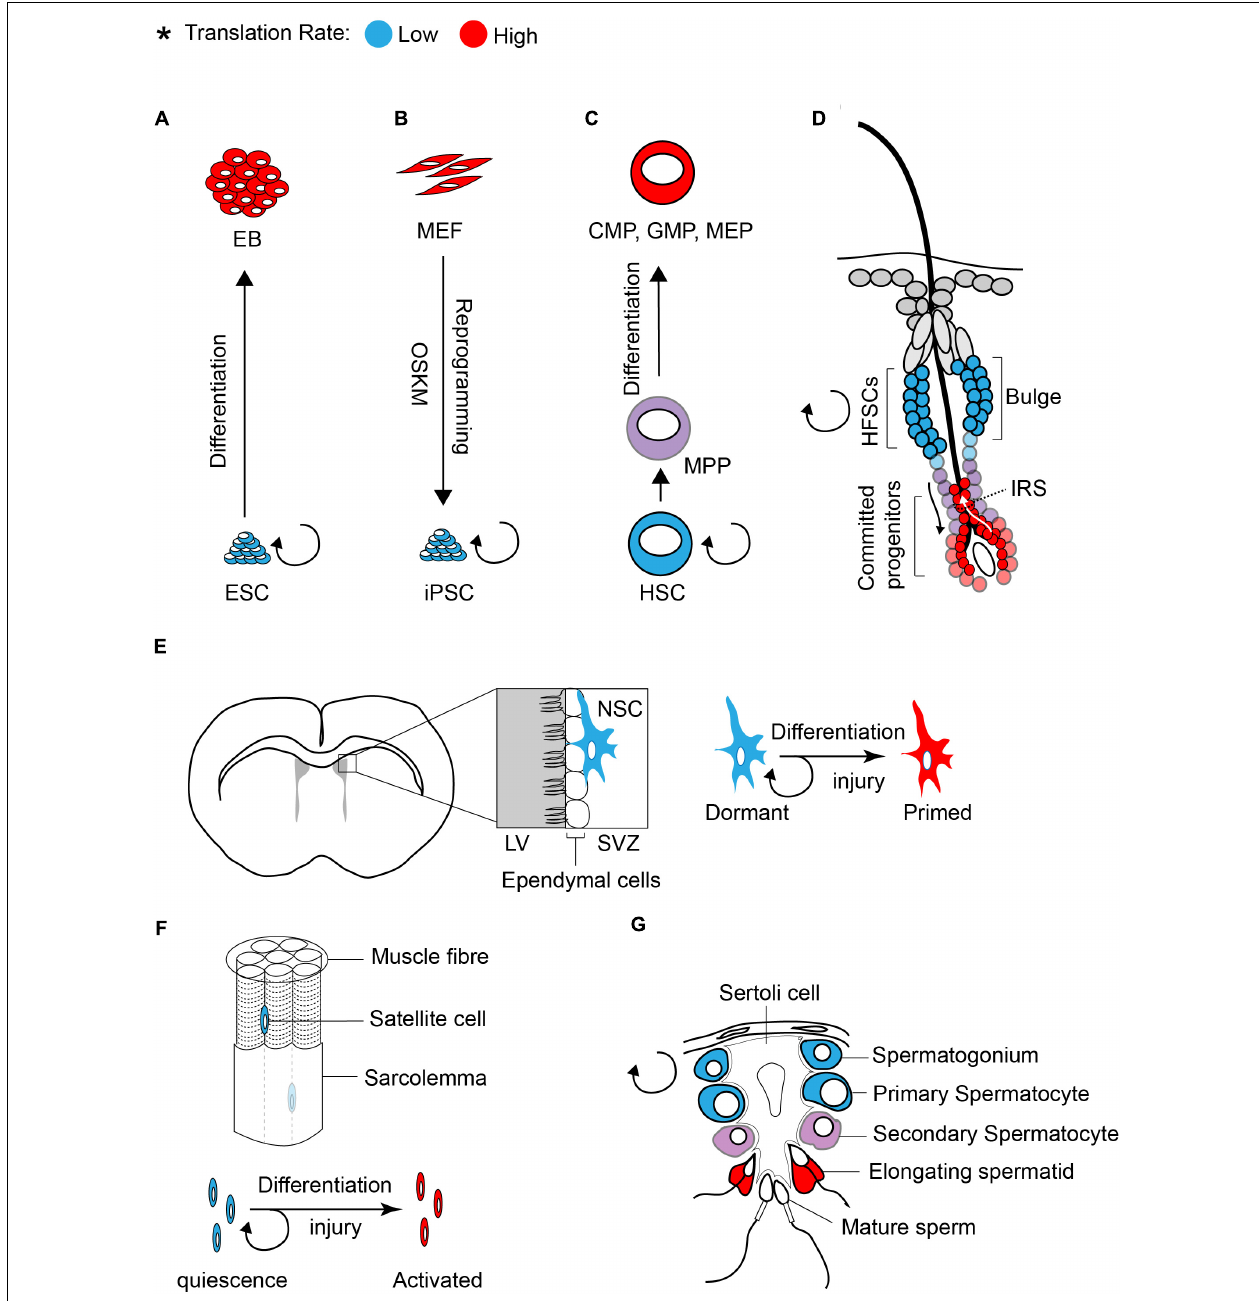
FIGURE 1 | Translation inhibition is a hallmark of stem cells. The rate of protein synthesis in pluripotent ESCs (A) or iPSCs (B) and in multipotent adult stem cells (C–G) is lower compared to early differentiating cells or progenitors. Blue and red color defines low and high translation rates,